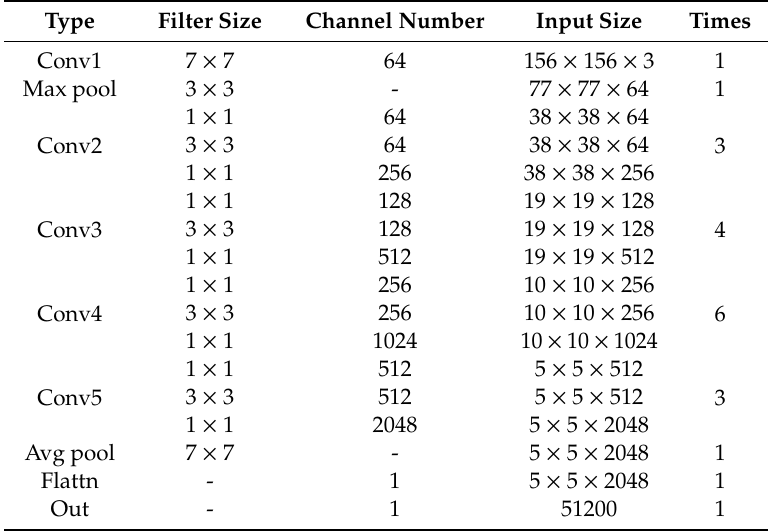
Table 2. Fundamental information about the ResNet-50 layers and associated parameters of the network